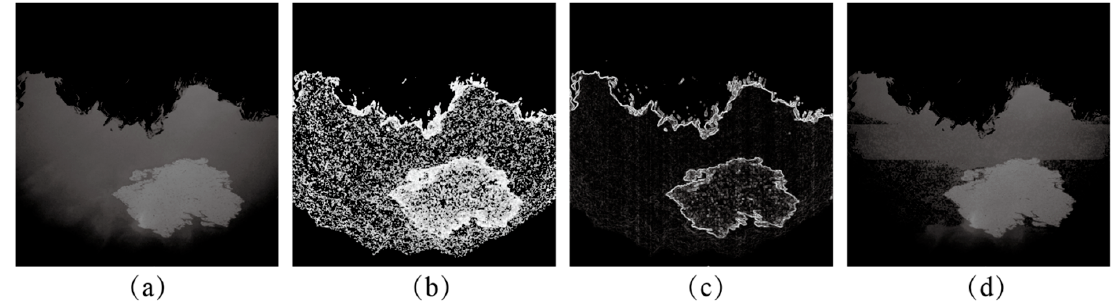
Figure 6. An example of the result of adaptive target enhancement (ATE). ( a ) The original image; ( b ) the local entropy image; ( c ) the gradient image; and ( d ) the ATE result.